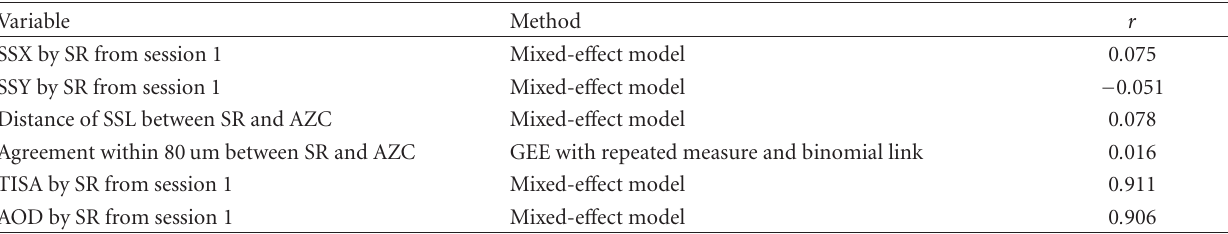
Table 8: Post hoc analysis of correlation of quadrants within an